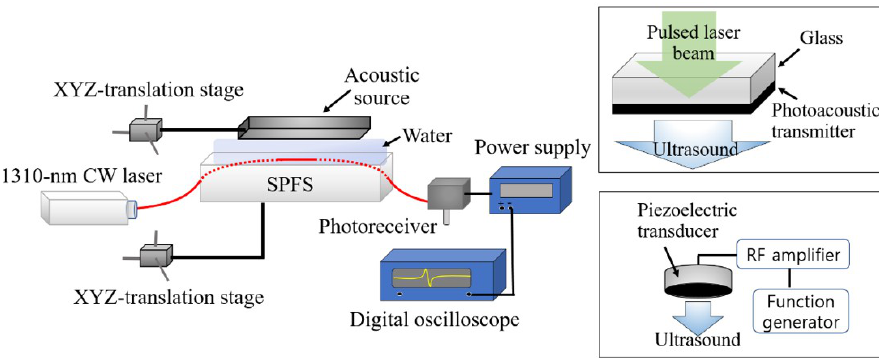
Figure 2. An experimental setup for sensor characterization. Two types of acoustic sources were used to characterize the side-polished fiber sensor (SPFS). The top inset box shows a schematic to use a photoacoustic transmitter (Cr or CNT-PDMS film) as the source, and the bottom inset box to use a piezoelectric transducer.